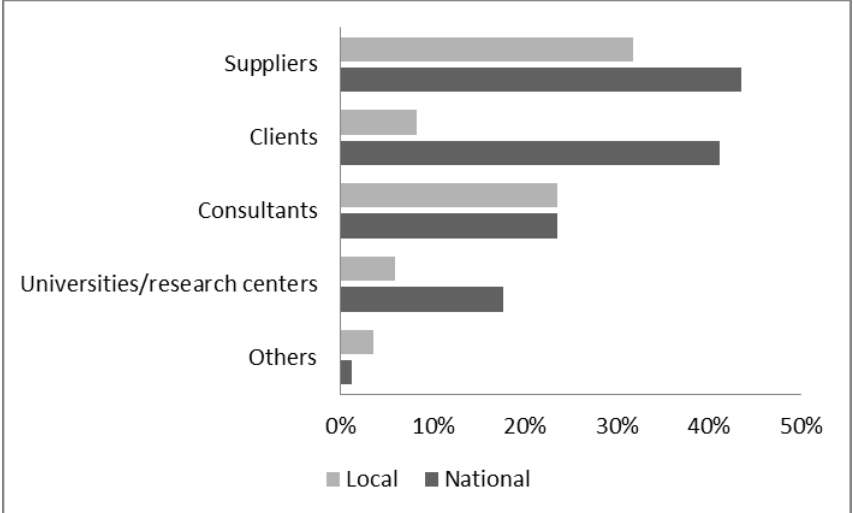
Figure 2: Strategic Nodes in the Network for Sustaining Innovation Activities (Year 2014-2016, n=85, % of